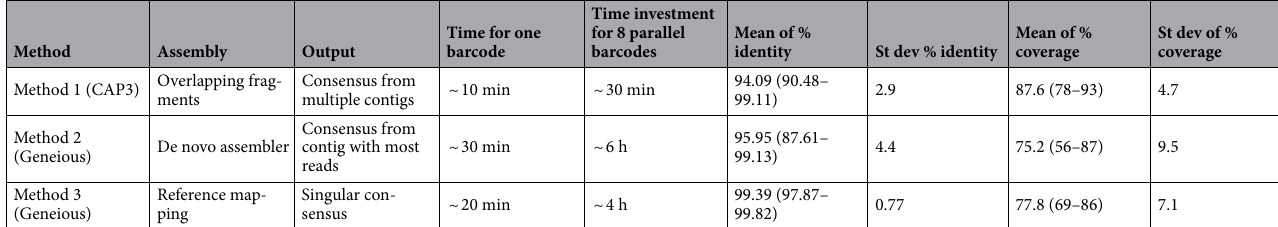
Table 3. Comparison of the three different MinION assembly methods (Method 1 CAP3 de novo assembly, Method 2 Genious de novo method and Method 3 Geneious reference mapping) used to assemble MinION